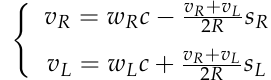
Figure 4. Relationship between a R , a L and ρ under typical road